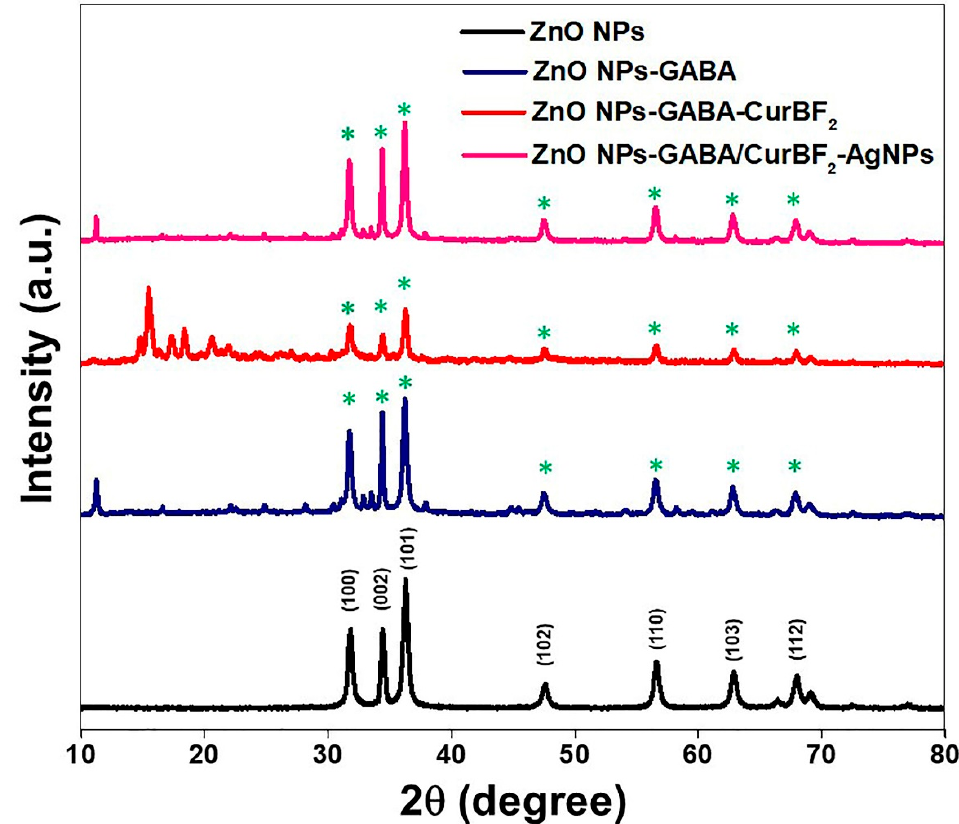
Figure 4. XRD patterns of ZnO NPs, ZnO NPs-GABA, ZnO NPs-GABA-CurBF 2 and ZnO NPs-GABA/CurBF 2 -AgNPs powder (the * on top of each peak in the ZnO NPs-GABA, ZnO NPs-GABA-CurBF 2 , and ZnO NPs-GABA/CurBF 2 -AgNPs diffractograms are peaks that also appear for ZnO NPs).